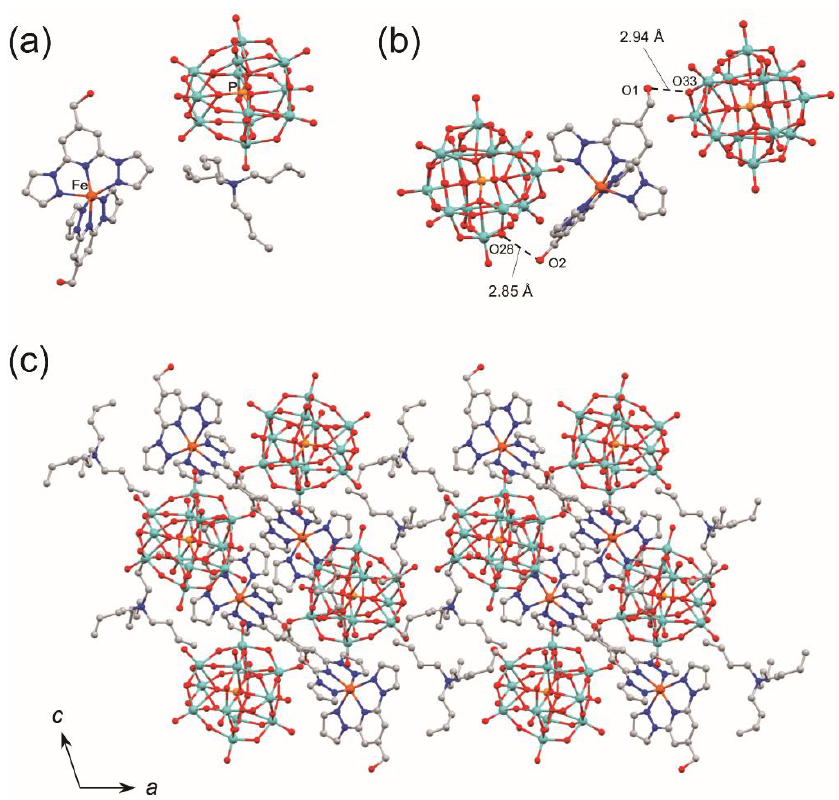
Figure 2. ( a ) X-ray structure of complex 1 ; ( b ) hydrogen bonding interactions between [Fe(dppOH) 2 ] 2+ and [PMo 12 O 40 ] 3 − and ( c ) packing structure of 1 viewed along the crystallographic b -axis. Color code: C: gray, N: blue, O: red, P: orange, Fe: brown, Mo: light blue (hydrogen atoms and solvent molecules omitted for clarity).